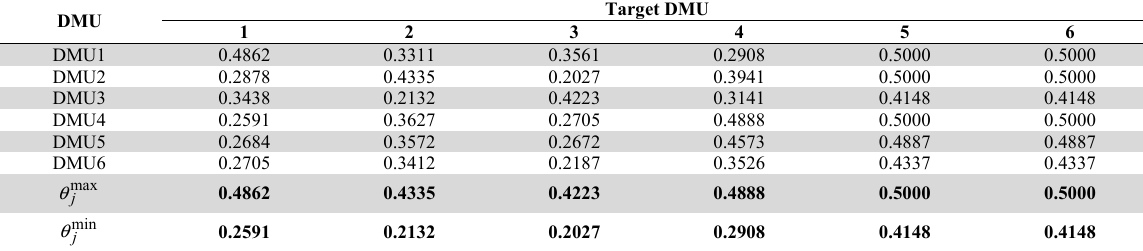
Combined CEM of six nursing homes